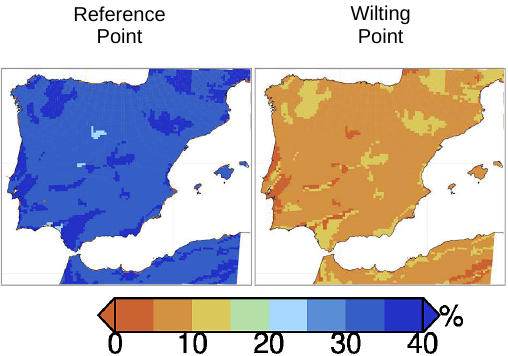
Figure 7. Wilting point and Reference Point for SM